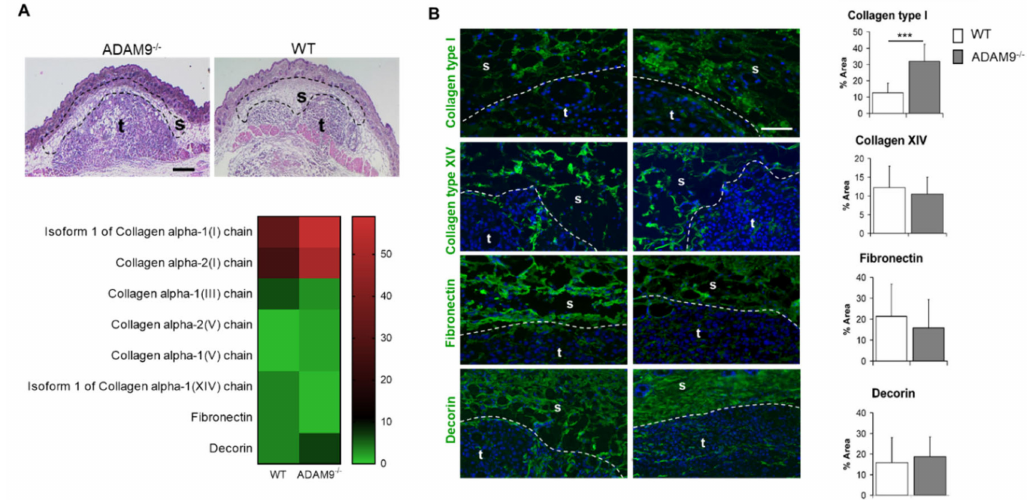
Figure 1. Differential expression of ECM proteins in the absence of ADAM9. ( A ) Analysis of ECM proteins at the tumor-stroma border. Black dotted lines indicate the microdissected areas used for mass spectrometry. t, tumor; s, stroma. Scale bar 50 µ m. In the lower heatmap are the relative intensities of protein expression in ADAM9 − / − and WT. ( B ) Immunofluorescence analysis of collagen type I, collagen type XIV, decorin, and fibronectin (green, nuclei: blue). As a negative control, sections were incubated in a blocking buffer without the primary antibody. Representative pictures are shown (WT n = 5; ADAM9 − / − n = 5). Scale bar 400 µ m. Staining was quantified in five different fields from 3 mice each genotype. Densities are shown as the percentage of the measured area; these are on the right. *** p <